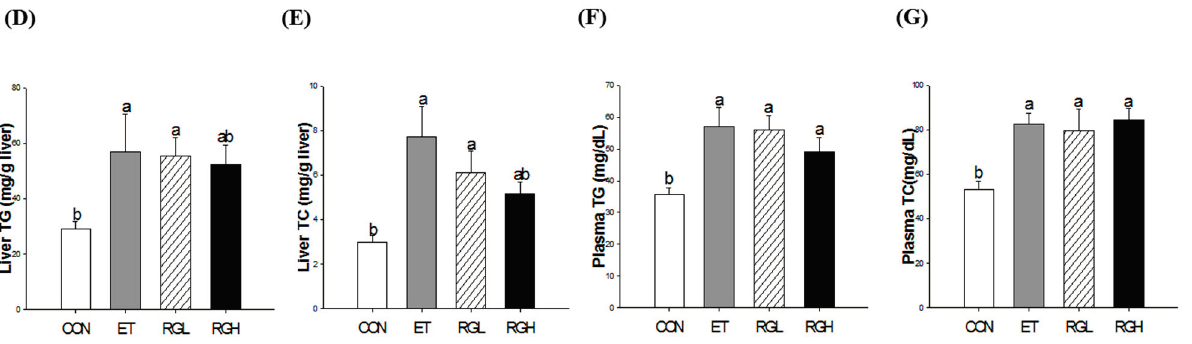
Figure 2. Lipid profiles in rats fed alcohol and KRG for 6 weeks. ( A ) Liver weight; ( B ) fat mass (epididymal, perirenal, and mesenteric); ( C ) plasma free fatty acids; ( D ) hepatic triglycerides; ( E ) hepatic total cholesterol; ( F ) plasma triglyceride; and ( G ) plasma total cholesterol. CON, normal control; ET, alcohol control; RGL, alcohol + 125 mg/kg KRG; RGH, alcohol + 250 mg/kg KRG. Alcohol was provided at 5% of the Lieber-DeCarli